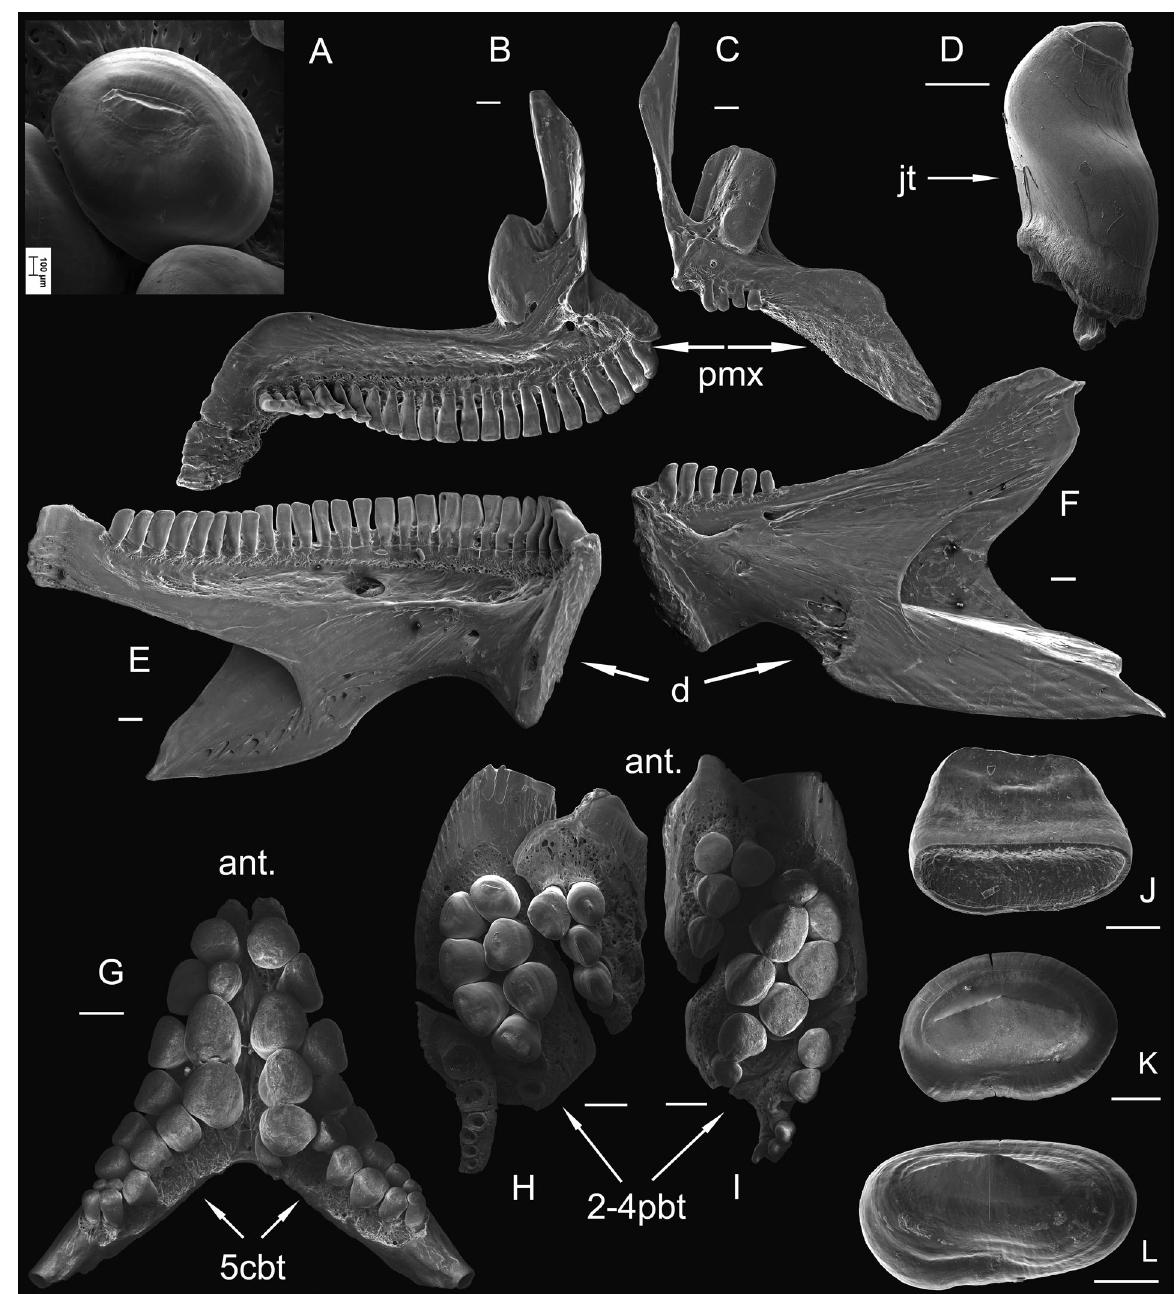
Fig. 2. Pleuronectes platessa Linnaeus. A , close-up of a tooth from the left pharyngobranchial toothplate; B , C , lingual aspect of the left and right premaxillae; D , a jaw tooth; E , F , lingual aspect of the left and right dentaries; G , dorsal aspect of the left and right lower pharyngeal tooth plates; H , I , ventral aspect of sets of left (H) and right (I) pharyngobranchial tooth plates; J–L , small single teeth from the unknown position in the mouth. A–H, GIT 584-89-54; B, GIT 584-163-1-1; C, GIT 584-163-1-2; D, GIT 584-89-49; E, GIT 584-163-2-1; F, GIT 584-163-2-2; G, GIT 584-122-3; H, GIT 584-89-54; I, GIT 584-122-4; J, GIT 584-94-45; K, GIT 584-94-33; L, GIT 584-94-34. Scale bar for A is 100 µm, for B, C, E–I 1 mm, for D 200 µm, for J–L 200 µm; A is close-up of H. Abbreviations: ant., anterior; d, dentary; jt, jaw tooth; pmx, premaxilla. For other abbreviations see Fig.